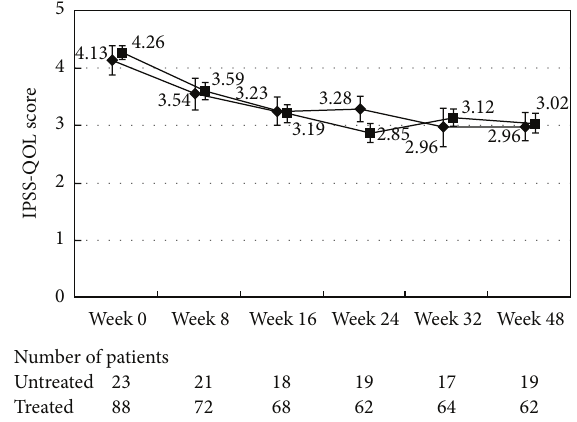
Figure 4: International Prostate Symptom Score quality of life score. The scores in the patients treated with an 𝛼 1-blocker or anticholinergic agent ( ◼ ) and the untreated patients ( ⧫ ) are shown. The values are LS mean ± SE. 𝑃 = 0.0554 (repeated